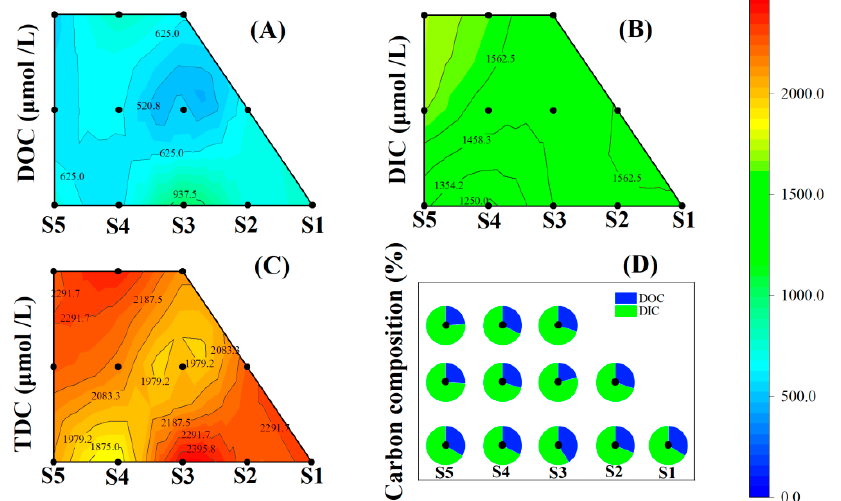
in JSB ( M ), and spatial distribution of DSi in JSB ( N ).